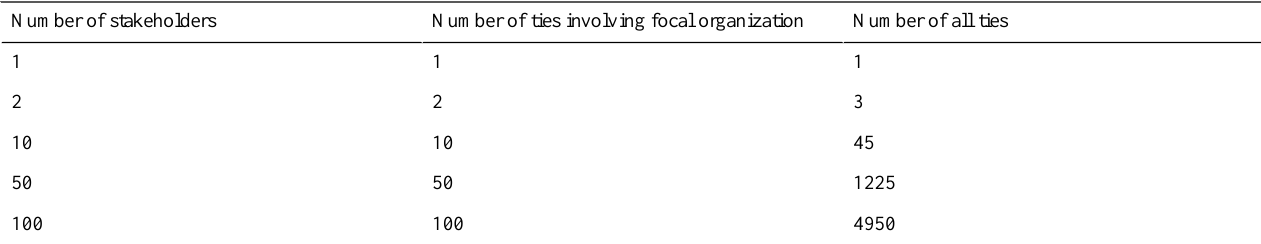
Number of all tiesNumber of ties involving focal organizationNumber of